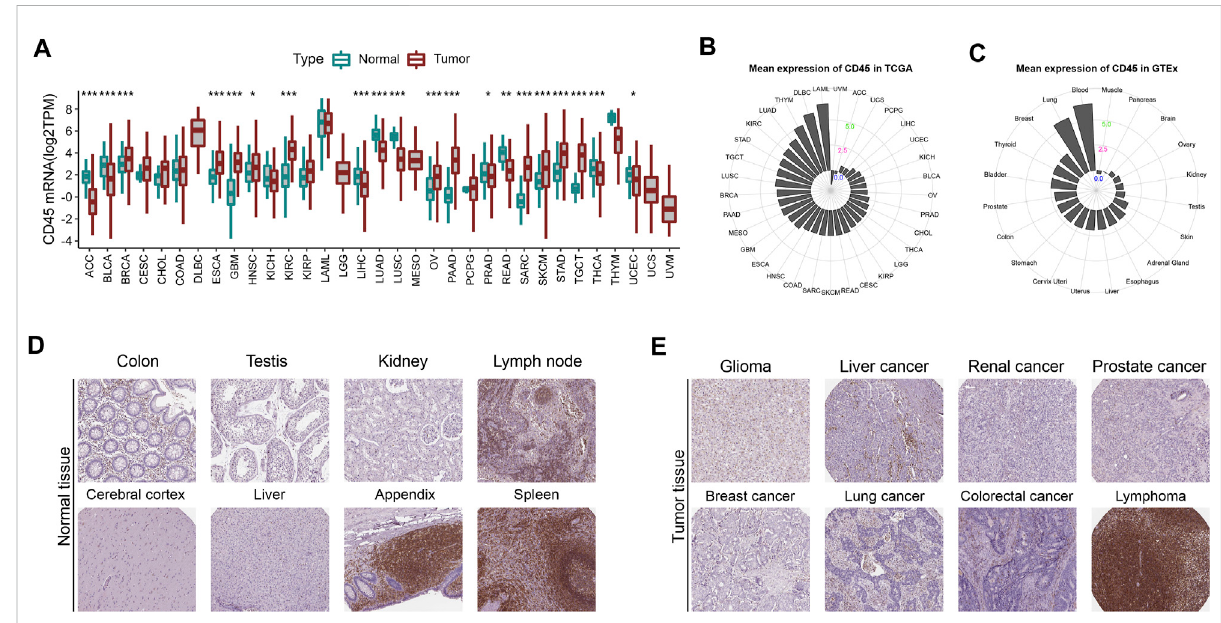
FIGURE 1 CD45 expression pro fi les in human normal and tumor tissues. (A) Pan-cancer analysis of CD45 expression in tumor tissues from TCGA and normal tissuesfrom GTEx. (B) CD45expression inhumantumor tissuesfromTCGA. Thelocationofthedot representsthemeanexpressionvalueof CD45 mRNA. (C) CD45 expression in human normal tissues from GTEx. The location of the dot represents the mean expression value of CD45 mRNA. The protein expression level of CD45 in human normal tissues (D) and tumor tissues (E) is displayed in the immunohistochemical images. * p < 0.05; ** p < 0.01 and *** p <